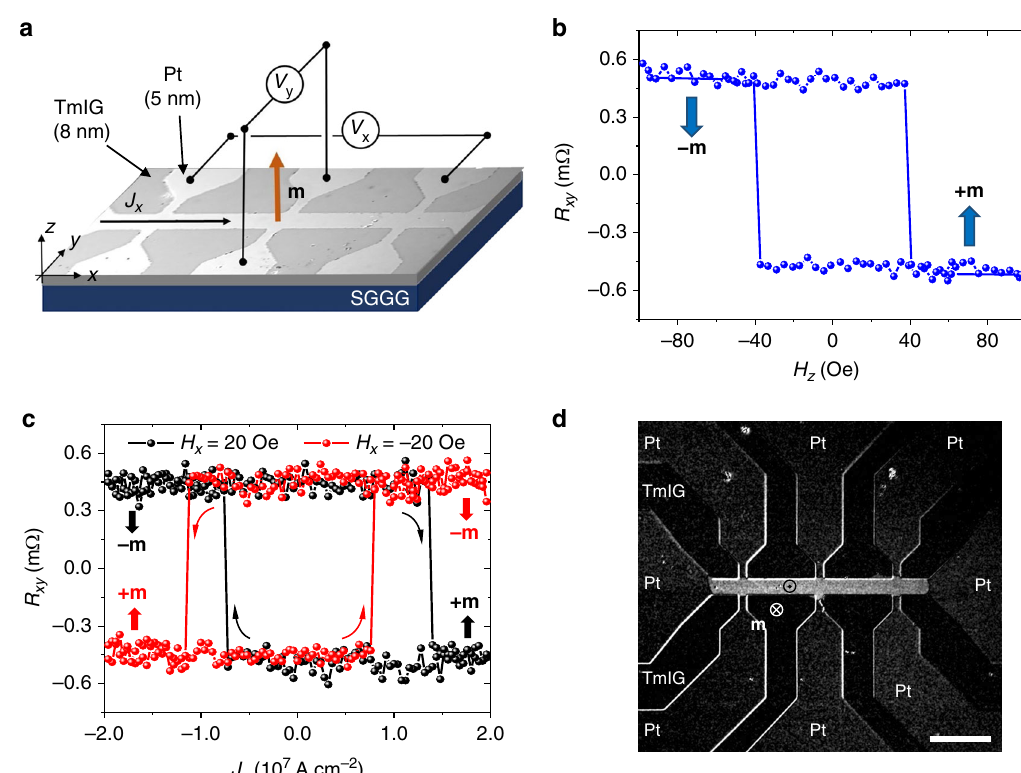
Fig. 1 Device schematics and local switching of TmIG. a Optical image of a Pt Hall bar patterned on TmIG with superposed electric wiring, coordinate system, and magnetization vector m . b Hall resistance R xy as a function of H z . The anomalous Hall-like signal arises from the interaction of the spin current generated in the Pt layer with the out-of-plane magnetization component m z of TmIG 27,54 , leading to a high (low) R xy for − m ( + m ). The data are shown after subtraction of a constant sample-dependent offset. c Electrical measurement of current-induced switching of TmIG ( t p = 1 ms, H x = + 20, black dots, and − 20 Oe, red dots). Note that, starting from a fi lm saturated in the – m state, higher current densities are required to induce forward switching relative to backward switching. The same behavior is observed for ± H x , thus ruling out a misalignment of the sample as a possible explanation for this effect. d Wide- fi eld differential MOKE image of a TmIG/Pt device after injection of a current pulse ( J x = 0.94 × 10 8 A cm − 2 , t p = 150 ns, H x = 100 Oe). The fi lm was initially saturated in the – m state by applying a magnetic fi eld H z = − 100 Oe. The bright contrast shows that only the TmIG region underneath the Pt current line has switched to + m . Scale bar, 40 μ